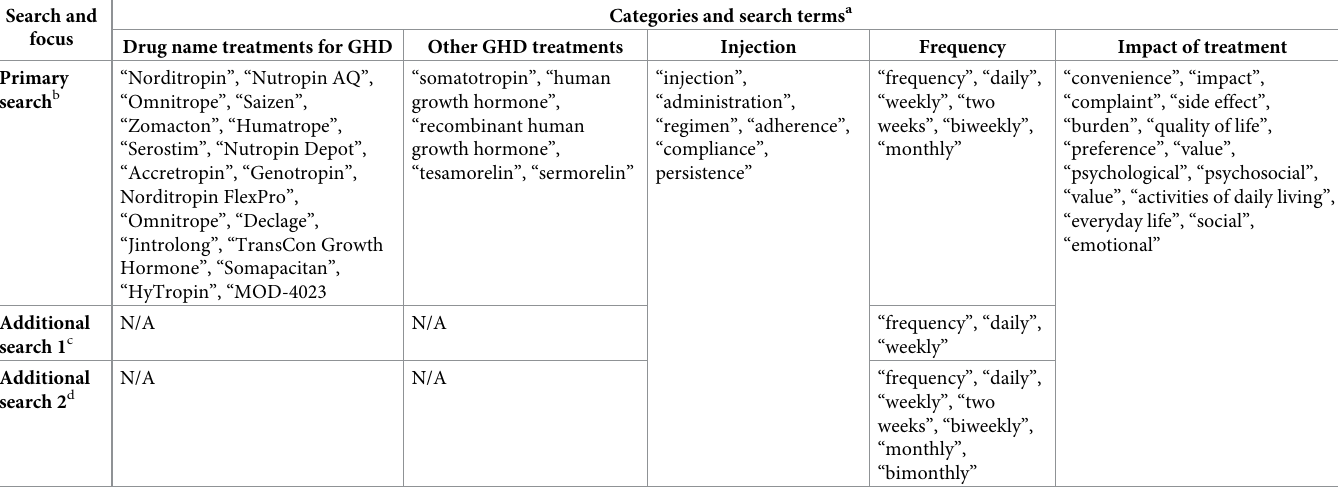
Table 1. Search terms applied in OvidSP to identify potential publications for